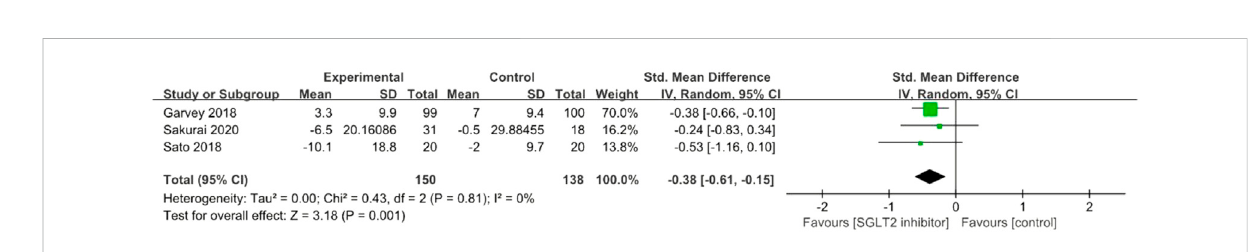
FIGURE 9 Forest plot of the effects of SGLT2 inhibitors on plasminogen activator